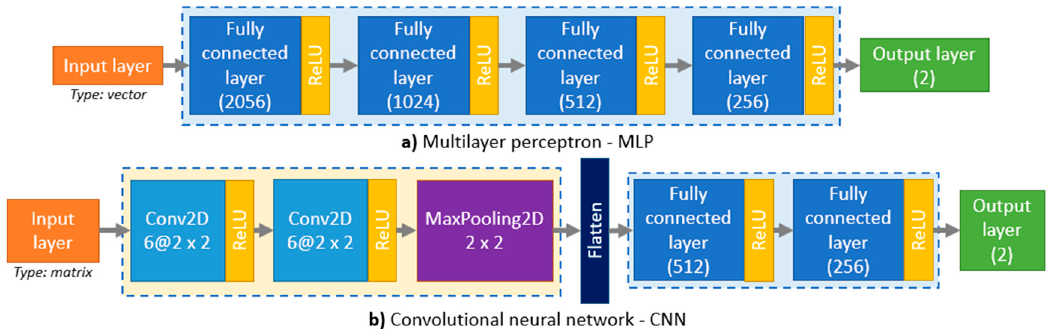
Figure 9. Block diagram of considered neural network architectures: multilayer perceptron—MLP ( a ), and convolutional neural network—CNN ( b ); The expression 6 @ 2 × 2 considers the depth of 6 (i.e., the number of convolutional filters in the given Feature Map), where the size of each filter corresponds to 2 × 2 pixels.